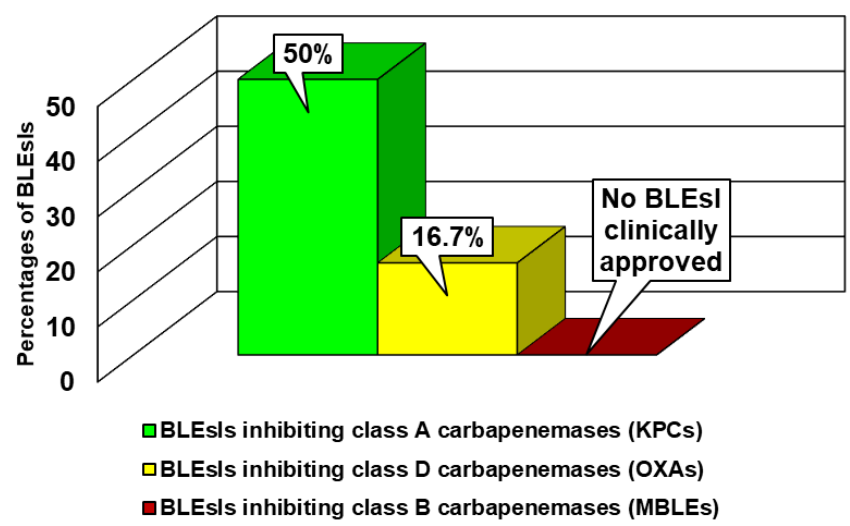
Figure 8. Percentages of approved BLEsIs active on the main classes of carbapenemases (class A KPCs, class D OXAs and class B, metallo carbapenemases).